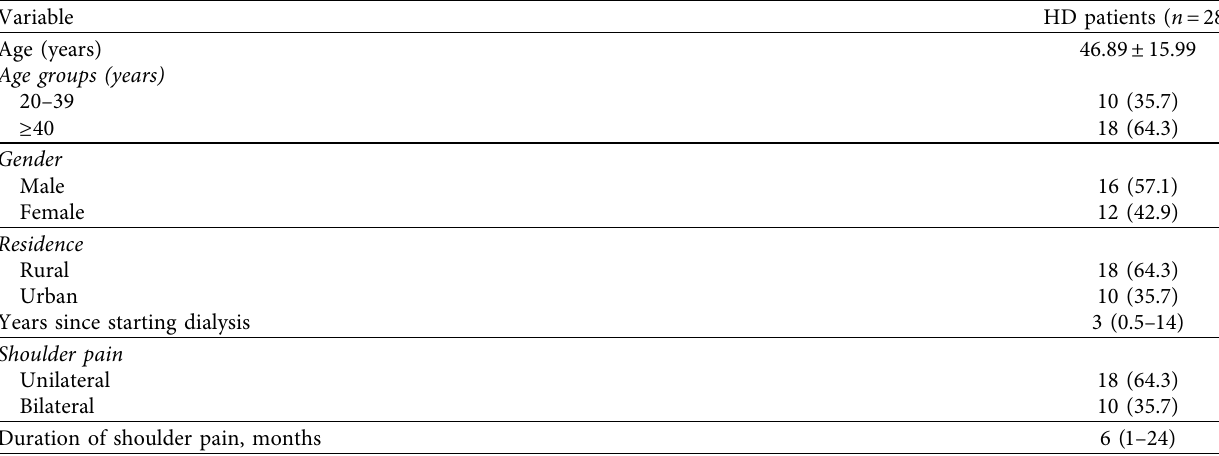
Table 1: Demographic and clinical data in the study HD patients ( n � 28).